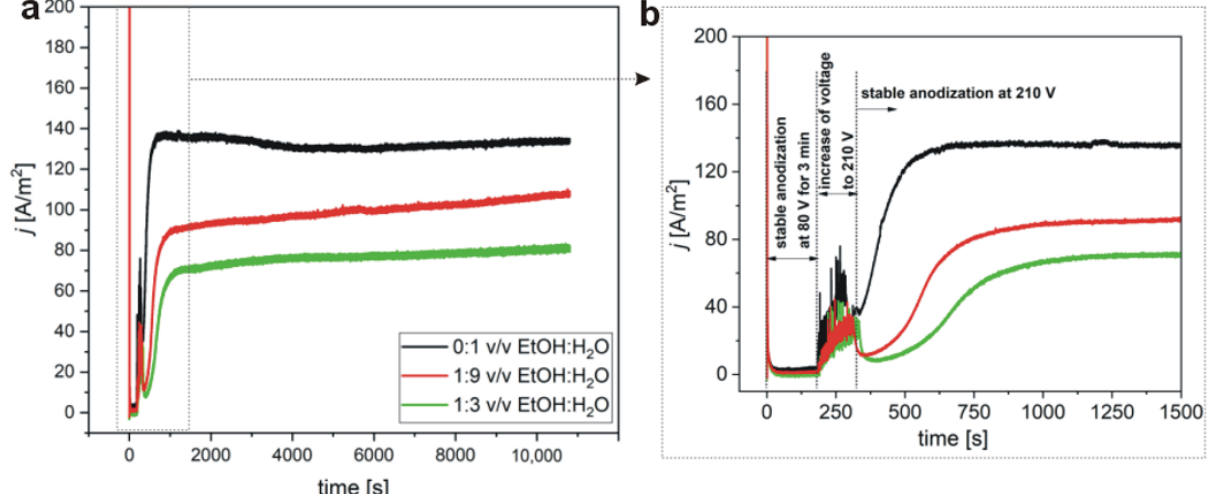
Figure 2. Current density vs. time curves recorded during I anodization at 38 °C in 0.3 M etidronic electrolytes without and with different amount of ethanol ( a ); a larger magnification of the j(t) curves ( b ).